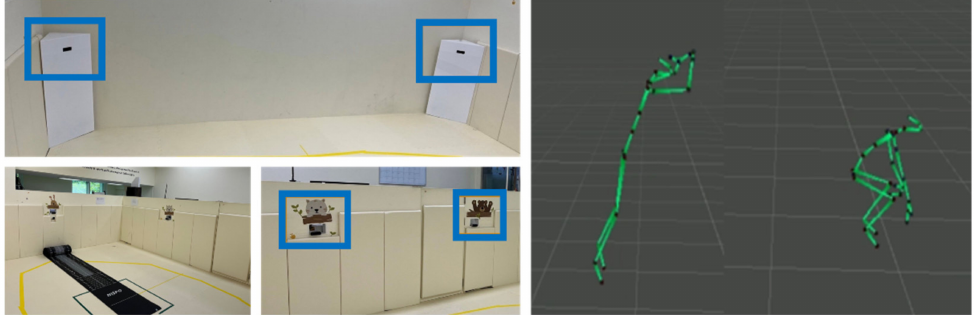
Figure 3. Azure Kinect and Intel Lidar setting for the standing long jump